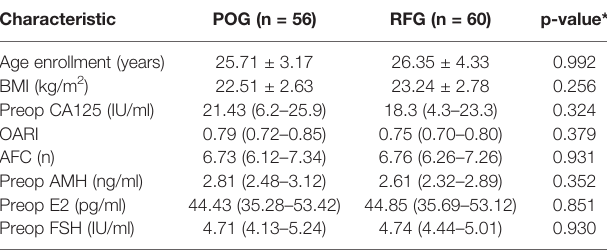
TABLE 1 | Baseline characteristics.